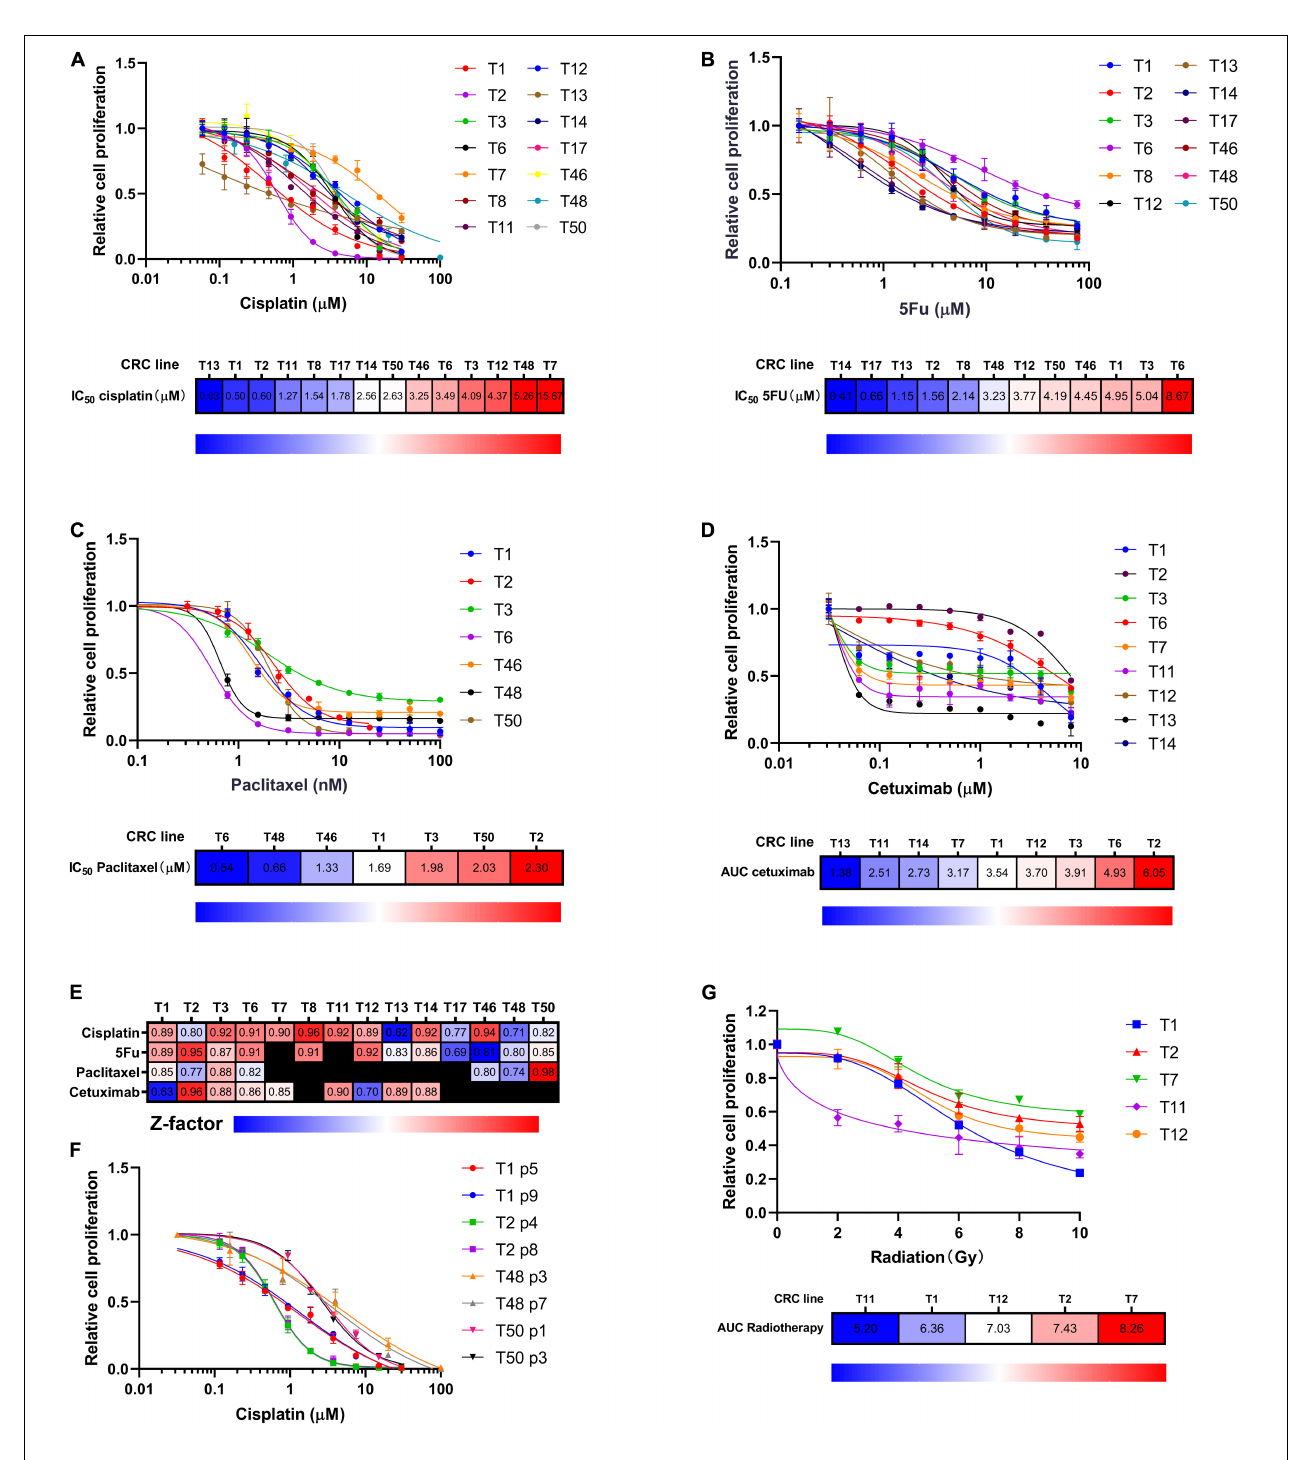
Frontiers in Cell and Developmental Biology |